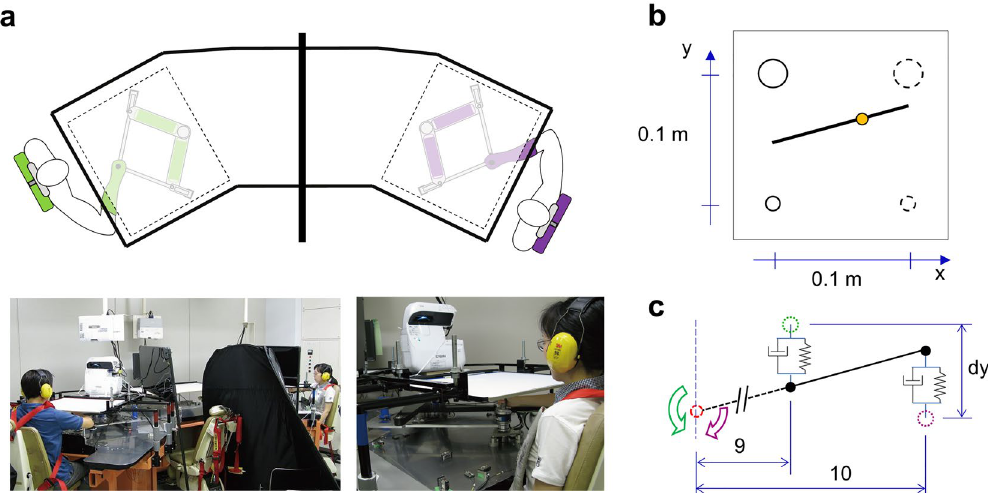
Figure 1. Experimental setup. ( a ) Each subject grasped and moved a robotic manipulandum located under a table. The two manipulanda were used to simulate the physical interaction between two human subjects. The virtual beam linking the two manipulanda was displayed on the table. The actual hand position was blocked from view. Visual feedback of the partner was blocked by black boards placed between subjects. Subjects wore headphones to eliminate sounds generated by the partner. Dyads performed the task without being informed that they were interacting through the virtual beam. ( b ) Visual feedback of the physical interaction task. Subjects were asked to move a 10-cm long and 1-kg weight virtual beam from the start position to the end position (bottom and top circles, respectively; 10 cm distance) while maintaining the beam horizontal. The tilt indicator (yellow circle) behaves like an air bubble in a level scale and slides towards the higher of the two beam’s ends. The top empty circle on the left denotes the target visible only to the left subject, whereas the top dashed circle on the right denotes the target visible only to the right subject. ( c ) Task dynamics. The beam behaves as if a pivot (red dashed circle) is located at one side of the beam far away from the hands (pivot to hand distance ratio between left and right agent was 9:10). Each hand generates a force to move the beam through a virtual spring-damper system between the hand position (green and purple dashed circles) and corresponding beam attachment position (black